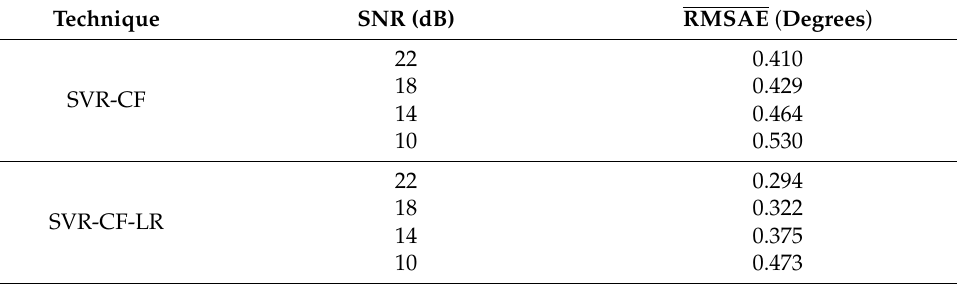
Table 2. RMSAE of the DoA estimate for SVR-CF and SVR-CF-LR at the